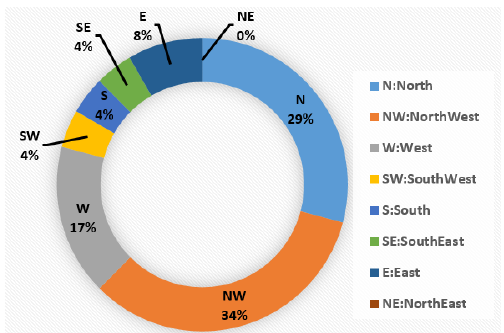
Fig.3. Wind direction statistics during wind shear at 36L and 01 runway corridor at BCIA (from 2018).